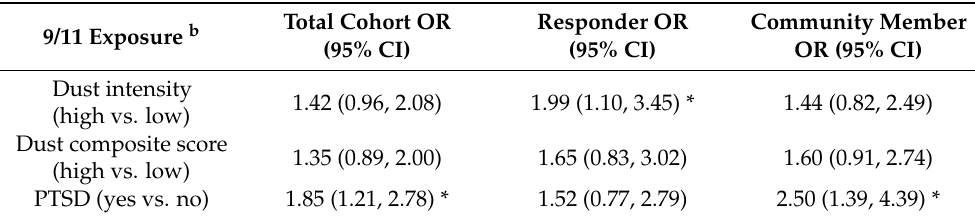
Table 2. Regression results (OR) of the association between 9/11 exposure and PTSD and systemic autoimmune disease a